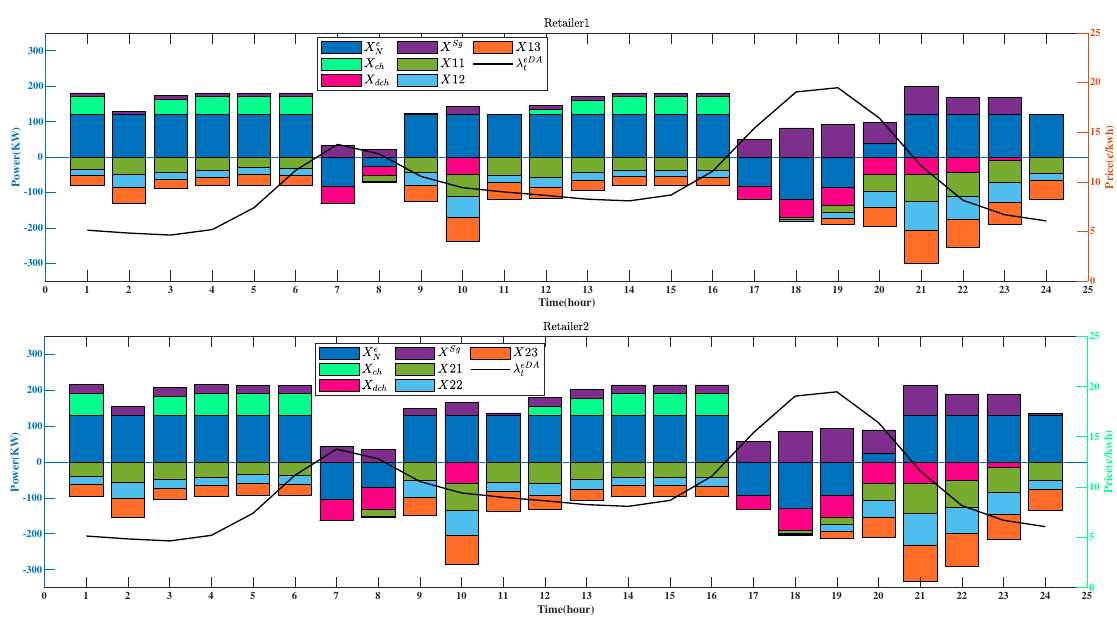
Figure 7. The plot of retailers’ power production from self-generation units, their transactions with the upstream network and prosumers, and charge and discharge of electrical storage, along with the price variation curve in the robust model.